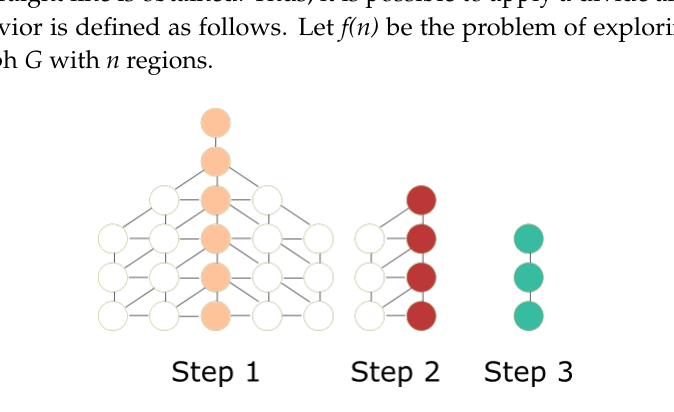
Figure 7. A central line divides the environment in half. Step 1 divides the Hextille in two symmetric parts. Step 2 continues to do this until there is only one straight line at Step